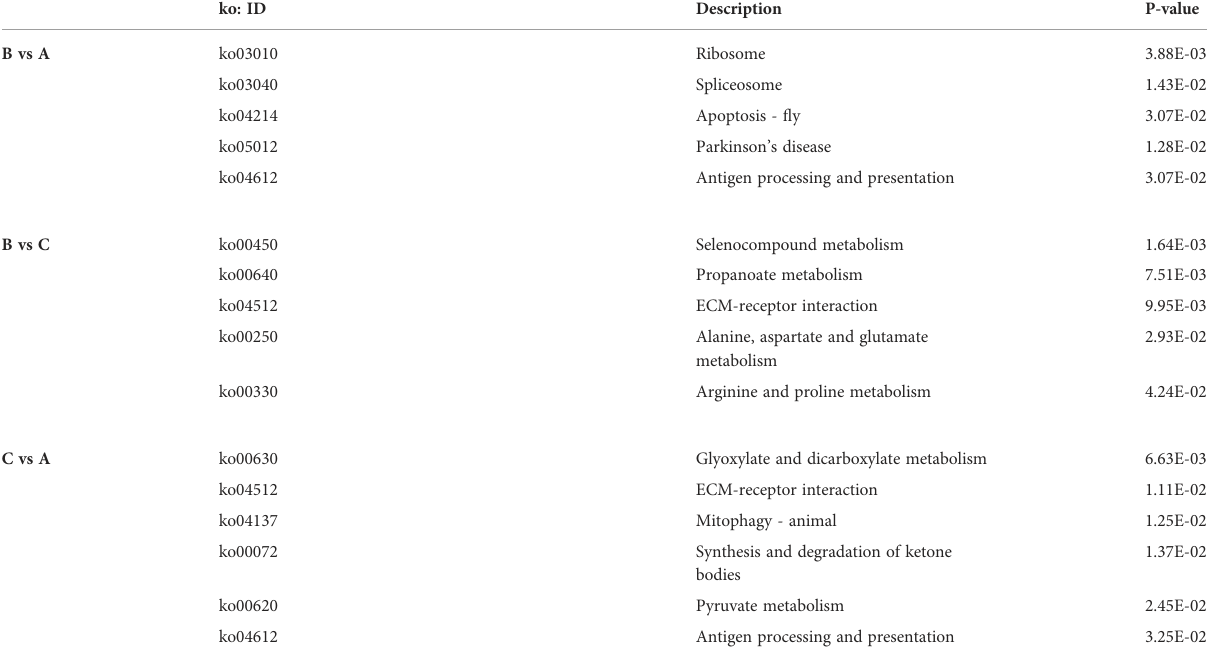
TABLE 3 KEGG enrichment for DEPs ( P < 0.05).